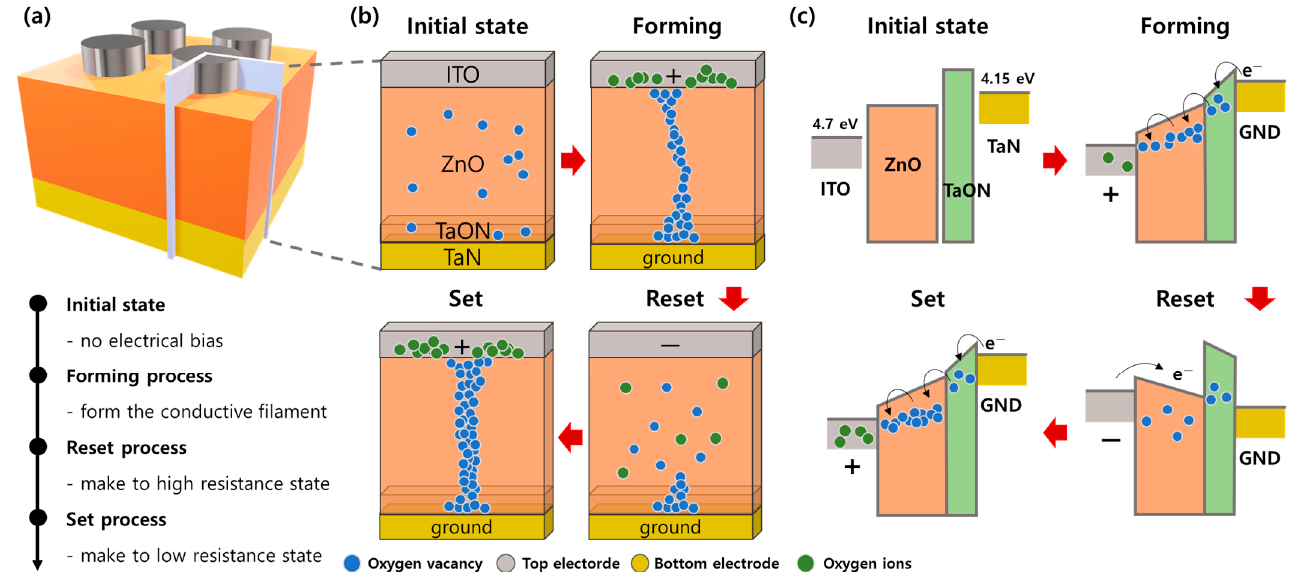
Figure 3. Schematic of switching process and mechanism. ( a ) ITO/ZnO/TaON/TaN schematic. ( b ) Movement of oxygen ions and oxygen vacancies by electrical force. ( c ) Energy band diagram of the device for each process.